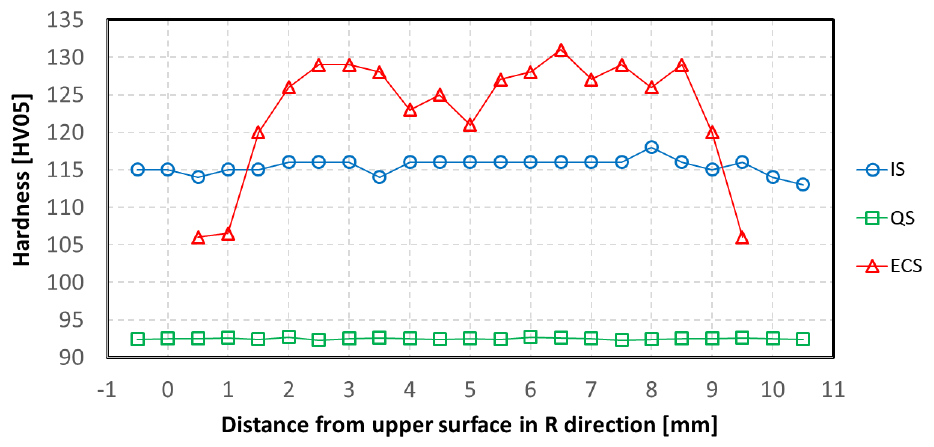
Figure 15. Micro-hardness profile along the cross sections of IS, QS and ECS materials.